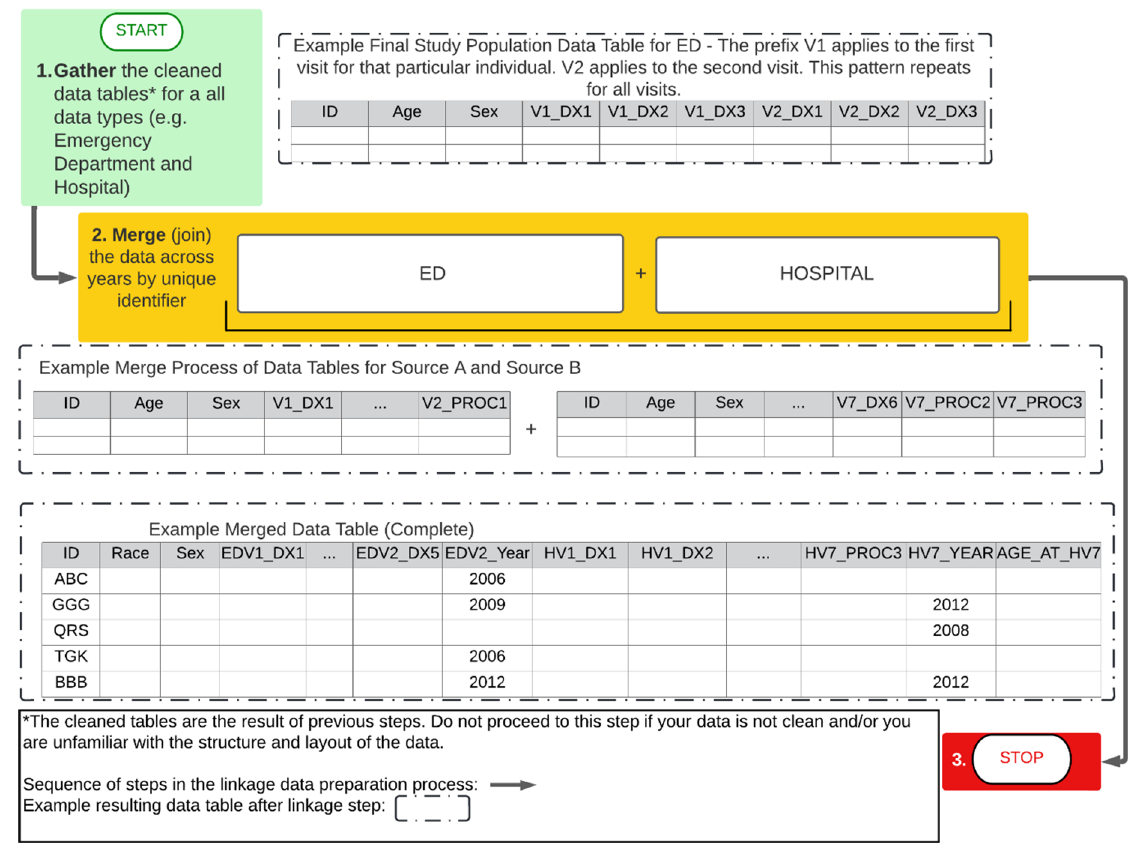
Figure 7: Steps to transform the concatenated data sources into a final merged data set